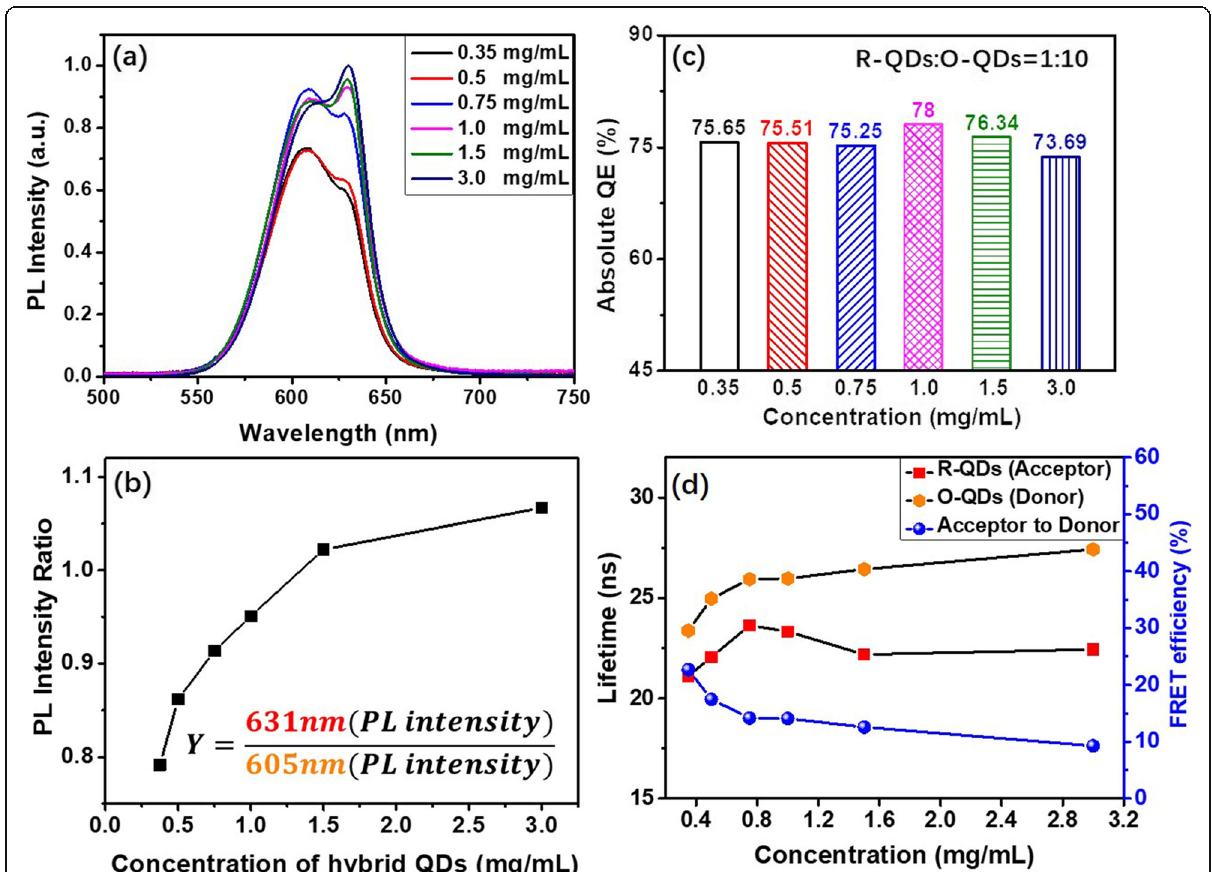
Fig. 6 PL spectra of as-prepared composite-QD silicone thin films with different concentrations ( a ) and their PL peak intensity ratios ( b ). QE of the as-prepared composite-QD silicone thin films ( c ). Lifetime of donor (orange dots) or acceptor (red dots), and FRET efficiency (blue dots) under different concentration of composite-QDs ( d